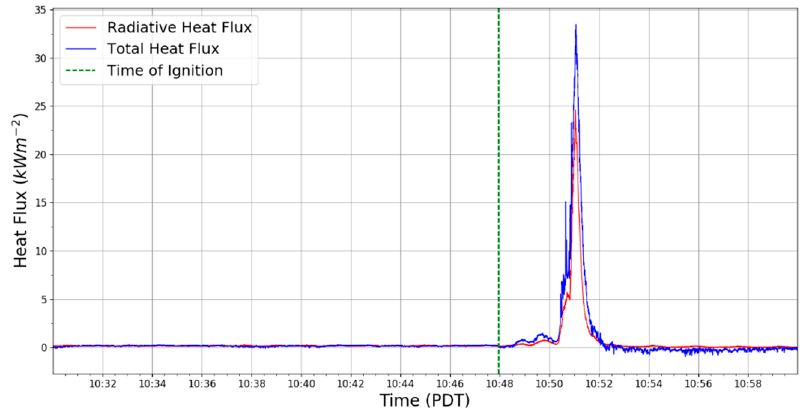
Figure 9. Time series of total and radiative heat fluxes measured during the FFP at the 12-m tower. Heat flux radiometers were mounted at 3 m AGL.